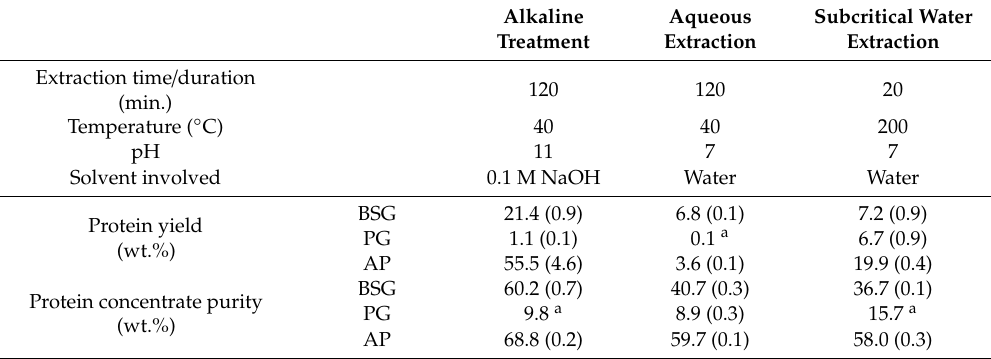
Table 1. A comparison between three extraction methods conditions and the obtained protein yield and